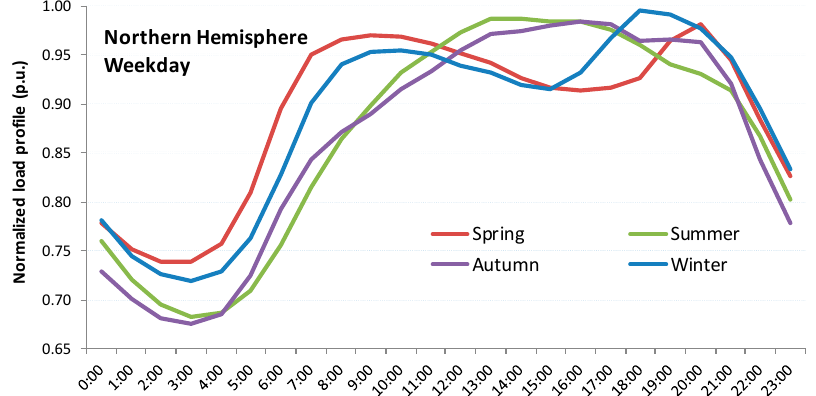
Figure 9. Standard normalised demand profiles for weekdays in the Northern Hemisphere. Source: [65,80–82] and self-elaboration.